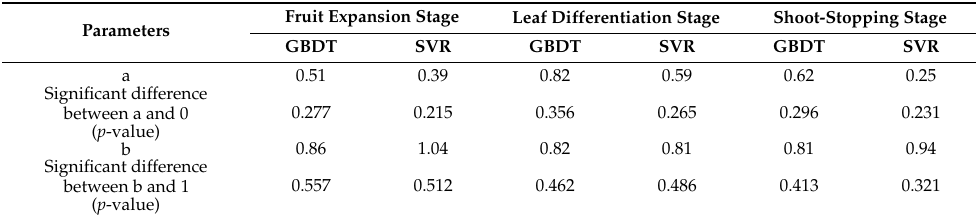
Table 10. The t -test statistics for the intercept a and the slope b of the curve fitted between the predicted and measured